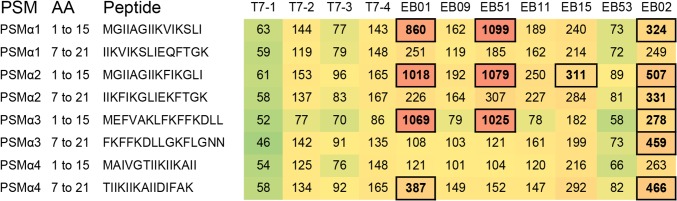
Heatmap of anti-PSMα1-4 reactivity.Plot of IgG responses from sera of volunteers (T7-1 till T7-4) and EB patients (EB01, 09, 51, 11, 15, 53, 02) against the N- (1 to 15) and C- (7 to 21) terminal parts of the PSMα1-4 peptides. Colors represent a gradient of reactivity against the various peptides (green is low and red is high). Peptides with a signal exceeding the median plus twice the standard deviation are boxed.